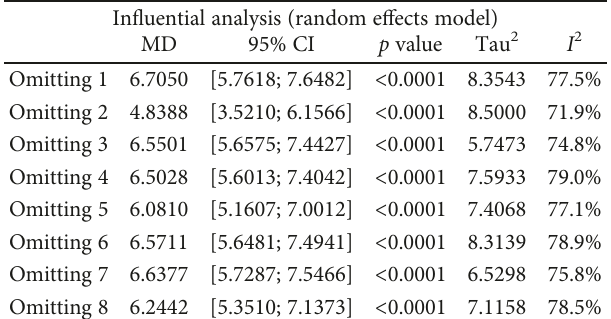
Table 4: The results of CD8+ T cell data sensitivity